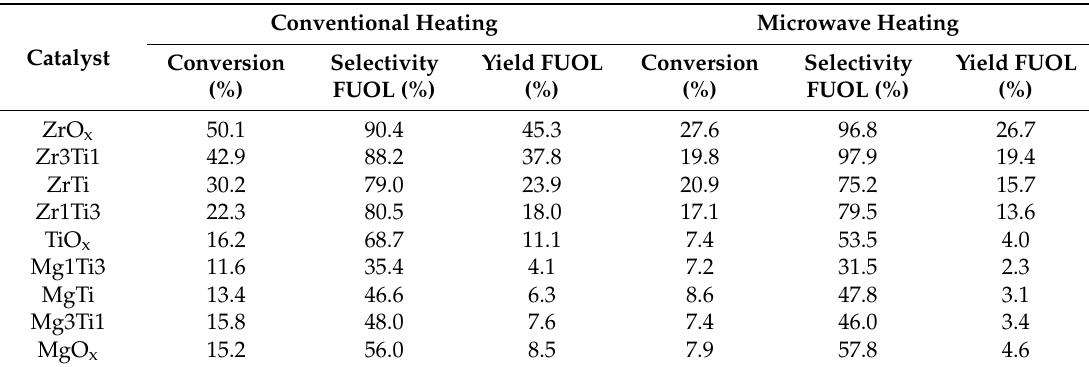
Table 4. Results obtained for experiments under conventional (t = 20 h) and microwave (t = 2 h) heating on the different solids expressed in terms of conversion, selectivity to furfuryl alcohol (FUOL), and FUOL yield. The reaction conditions were as follows: 100 ◦ C, molar propan-2-ol/furfural ratio